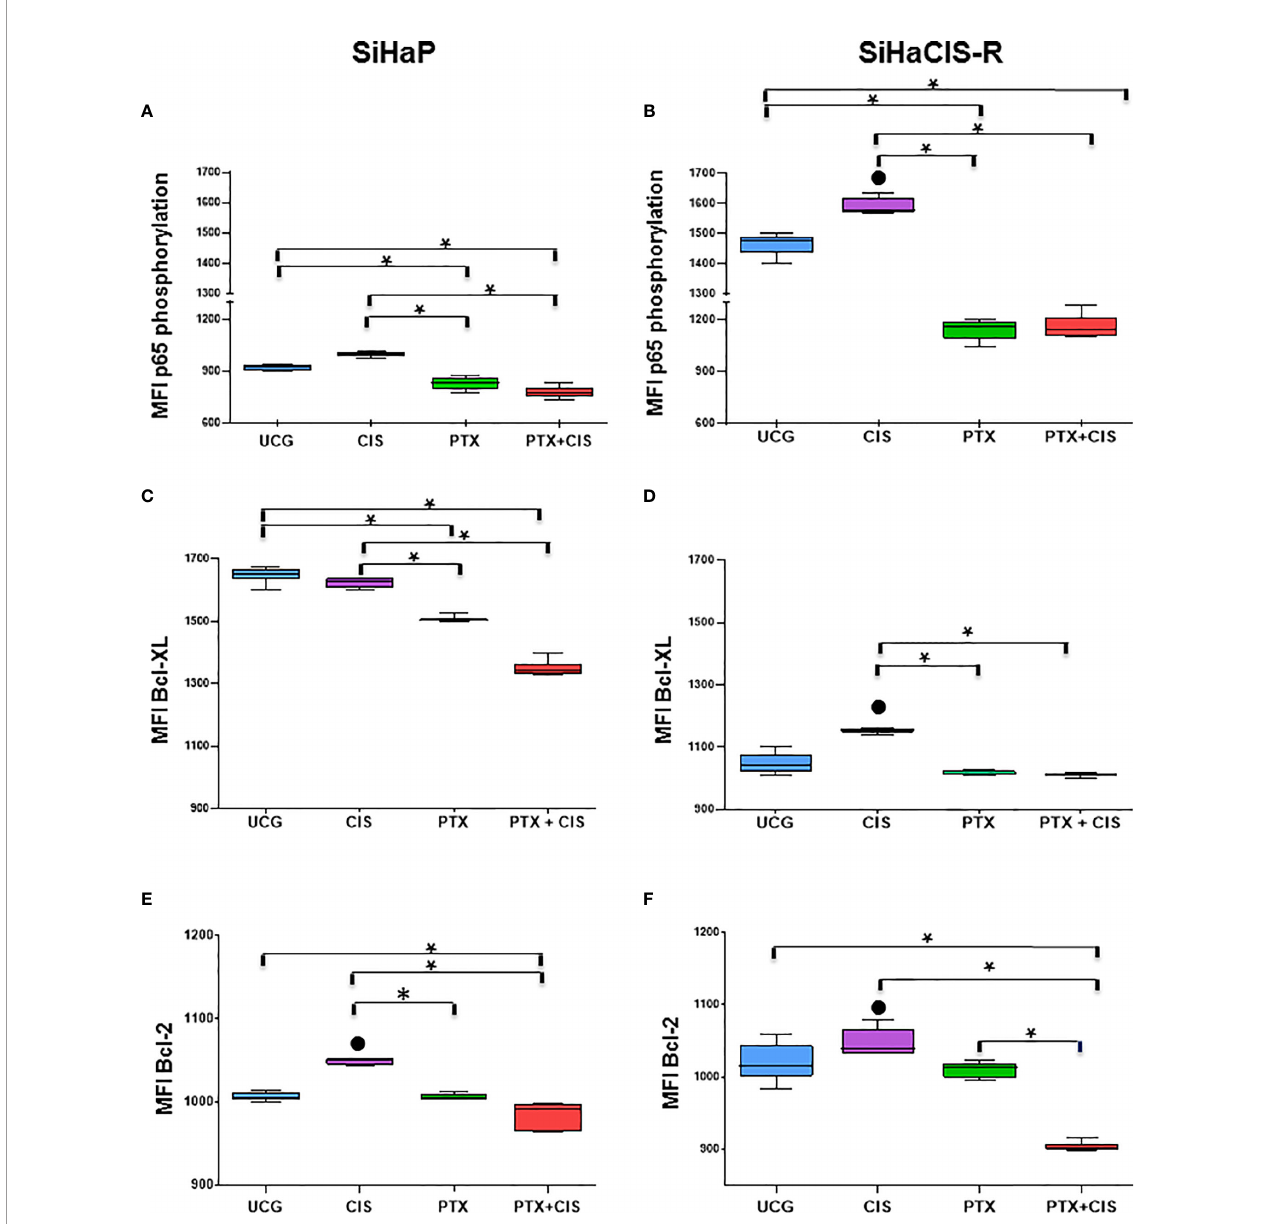
FIGURE 4 | PTX decreased NF- k B/p65 phosphorylation and Bcl-2 and Bcl-XL anti-apoptotic proteins in SiHaP and SiHaCIS-R cells. SiHaP and SiHaCIS-R cells were treated with CIS (30 m M), PTX (4 mM), or PTX + CIS (4 mM + 30 m M) for 24 h to determine Bcl-XL and Bcl-2 expression. For the assessment of p65 phosphorylation, the cells were treated for 1 h. Data are expressed as the Mean Fluorescence Intensity (MFI) of p65 phosphorylation (A, B) , Bcl-XL (C, D) , and Bcl-2 (E, F) anti-apoptotic proteins. * p < 0.001 = statistical signi fi cance after the comparison between PTX group or the PTX + CIS group vs. CIS group or UCG groups in SiHaP cells or SiHaCIS-R cells. ● p < 0.001 CIS group vs. UCG group in SiHaP cells or SiHaCIS-R cells. UCG, Untreated Control group; CIS, CISplatin; PTX,